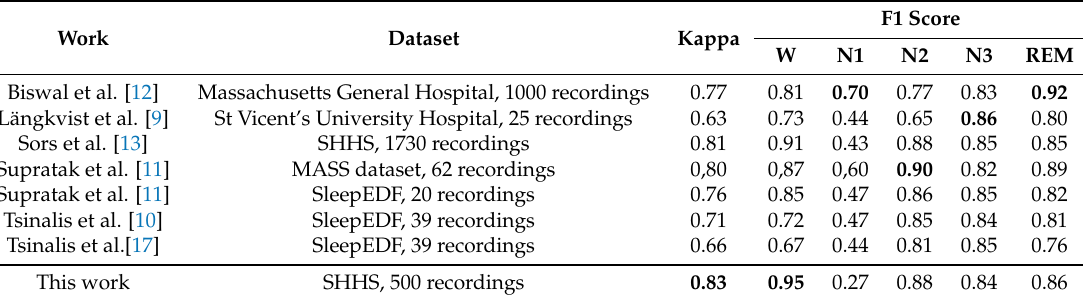
Table 1. Performance achieved in previous